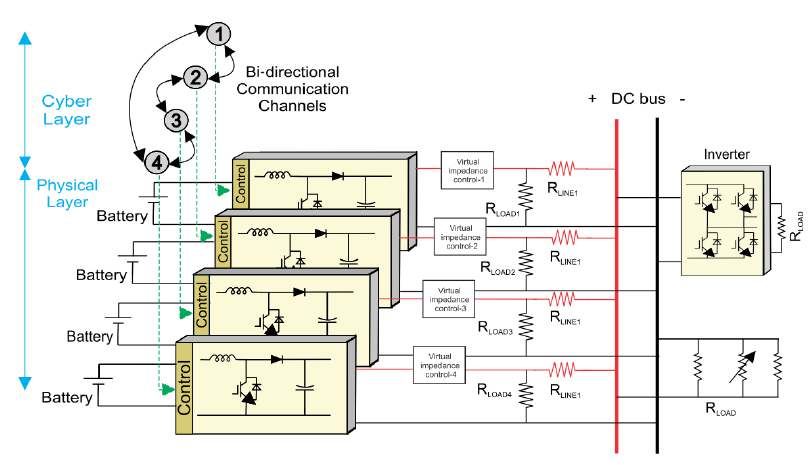
Figure 37. Virtual impedance control at nodes of